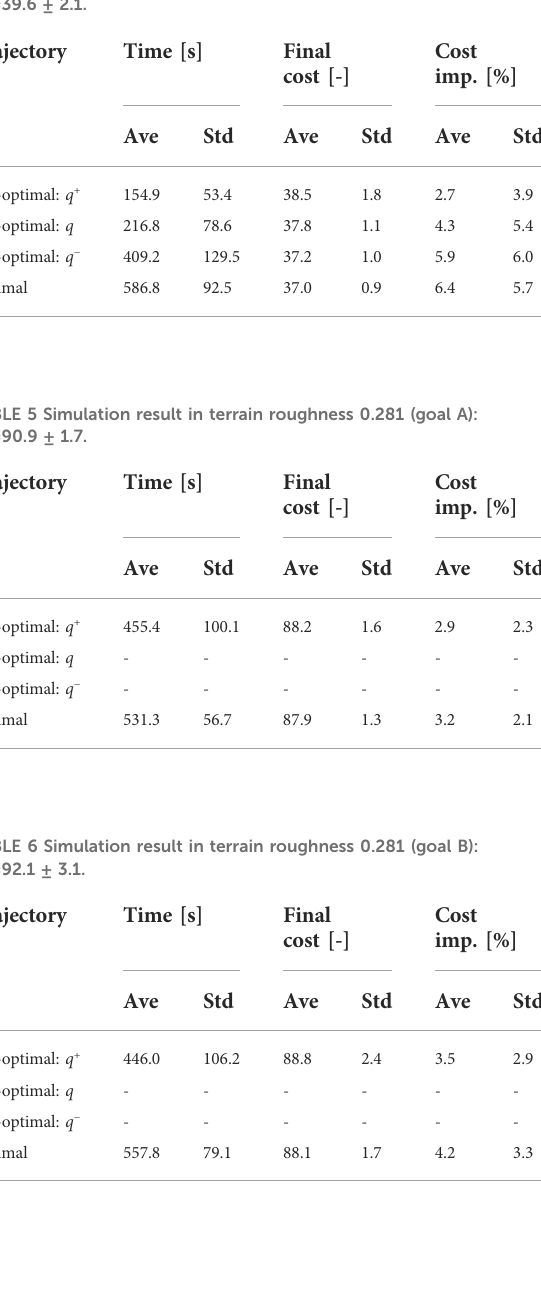
TABLE 4 Simulation result in terrain roughness 0.207 (goal B): C 0 =39.6 ± 2.1.